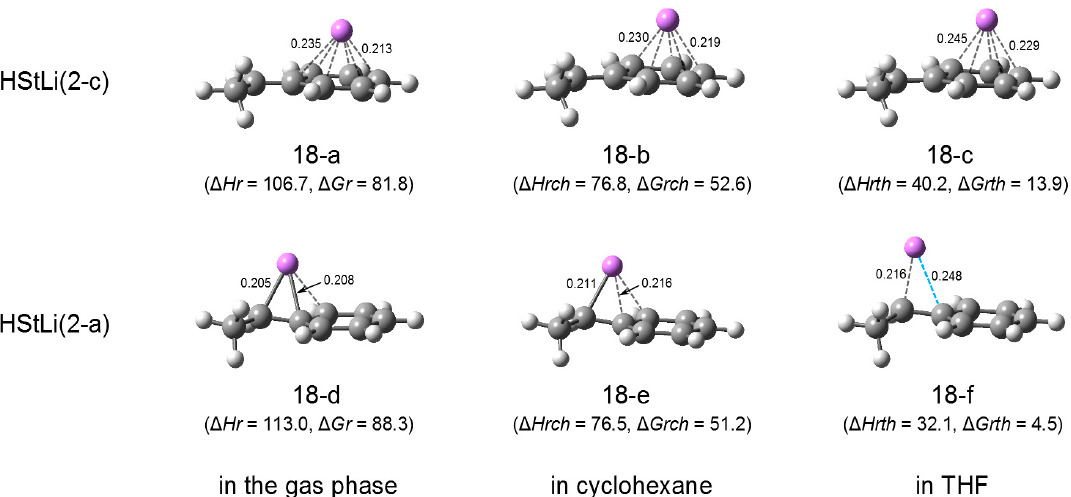
Figure 18. Geometries and relative energies of HStLi(2-c) ((18-a) through (18-c)) and HStLi(2-a) ((18-d) through (18-f)) in different environment. In (18-a) through (18-c), the shortest and the longest distances of the (phenyl)C–Li bonds are shown, and in (18-d) through (18-f), the distances of the ( α )C–Li and (ipso)C–Li bonds are shown. ∆ Hr and ∆ Gr , the relative enthalpy and relative free energy in the gas phase, are expressed in kJ·mol –1 . ∆ Hrch and ∆ Grch are the relative enthalpy and relative free energy in cyclohexane, and ∆ Hrth and ∆ Grth are those in THF, in kJ·mol − 1 . NPA charges were calculated for the α -carbon and Li atom of HStLi(2-a). The atomic α -carbon